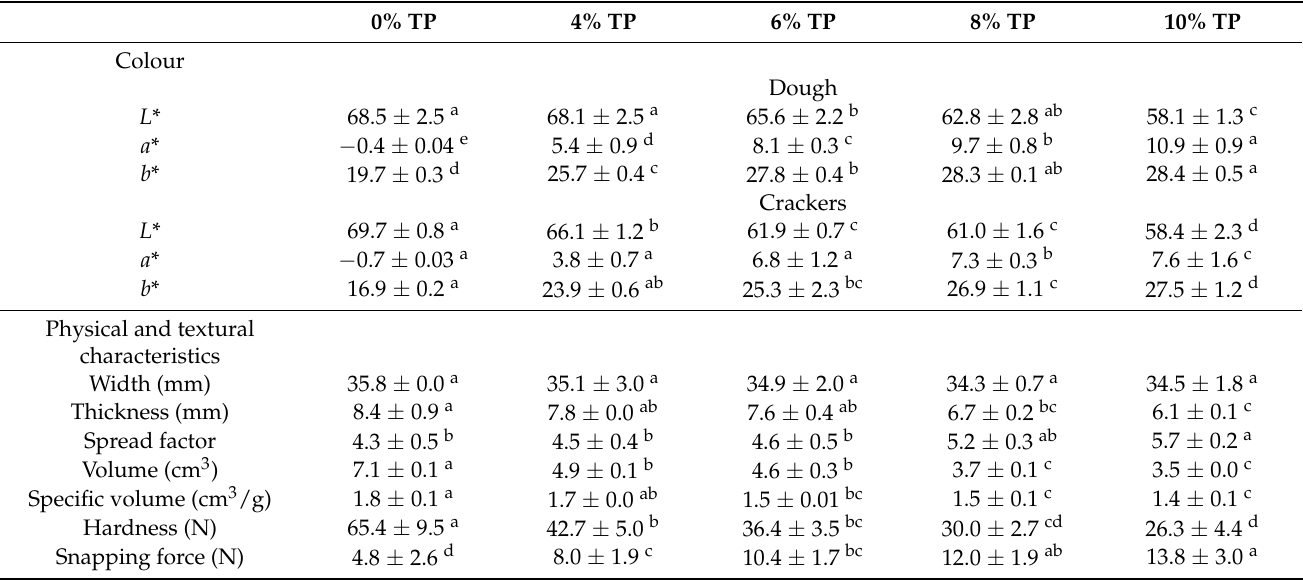
Table 2. Colour, physical, and textural characteristics (mean ± standard deviation) of crackers with increasing quantities of tomato pomace